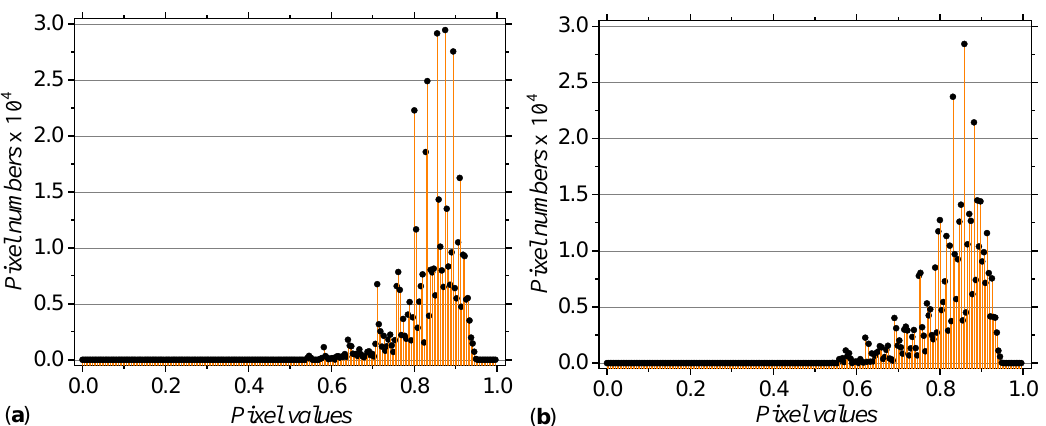
Figure 4. Histograms of the pixel levels in the images corresponding to models M5 ( a ) and M6 ( b ), shown in Figure 2 lower